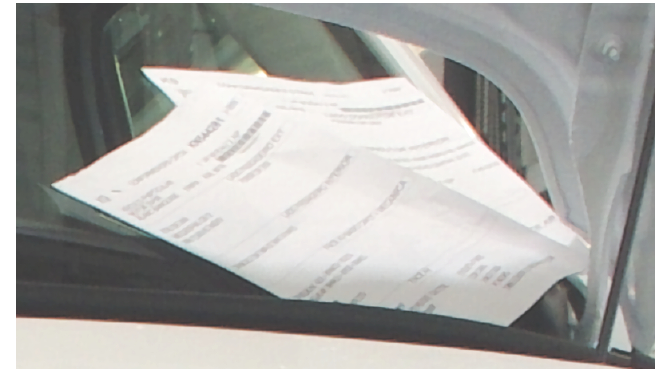
Figure 1. Paper conformity